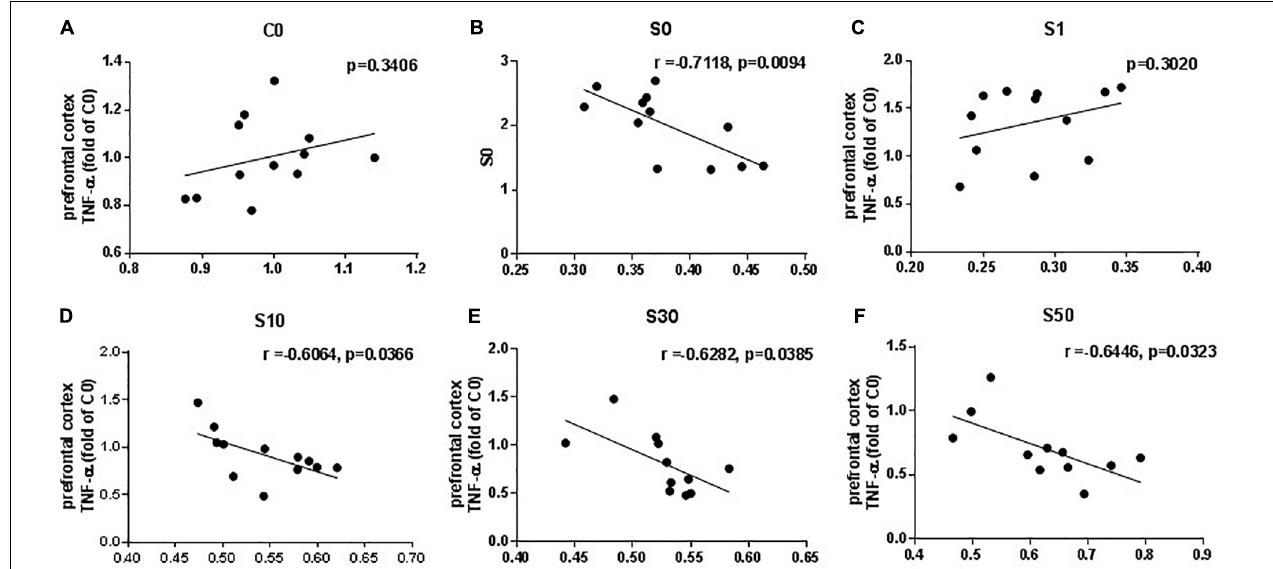
FIGURE 7 | Linear regression analysis between Bmal1 mRNA level and proinflammatory cytokines TNF- α in the prefrontal cortex induced by exploratory laparotomy under sevoflurane anesthesia. The mRNA level of Bmal1 was negatively correlated with TNF- α in the prefrontal cortex in the surgery group pretreated with vehicle (B) and nobiletin (NOB) at doses off 10 (D) , 30 (E) and 50 mg/kg (F) . However, there was no linear correlations between Bmal1 mRNA level and TNF- α in the control group without surgery (A) , or the surgery group with NOB 1mg/kg (C) . C0: control group without surgery: S0: surgery group with vehicle pretreatment; S1, S10, S30, S50: surgery group with NOB 1,10,30, 50mg/kg pretreatment; n =